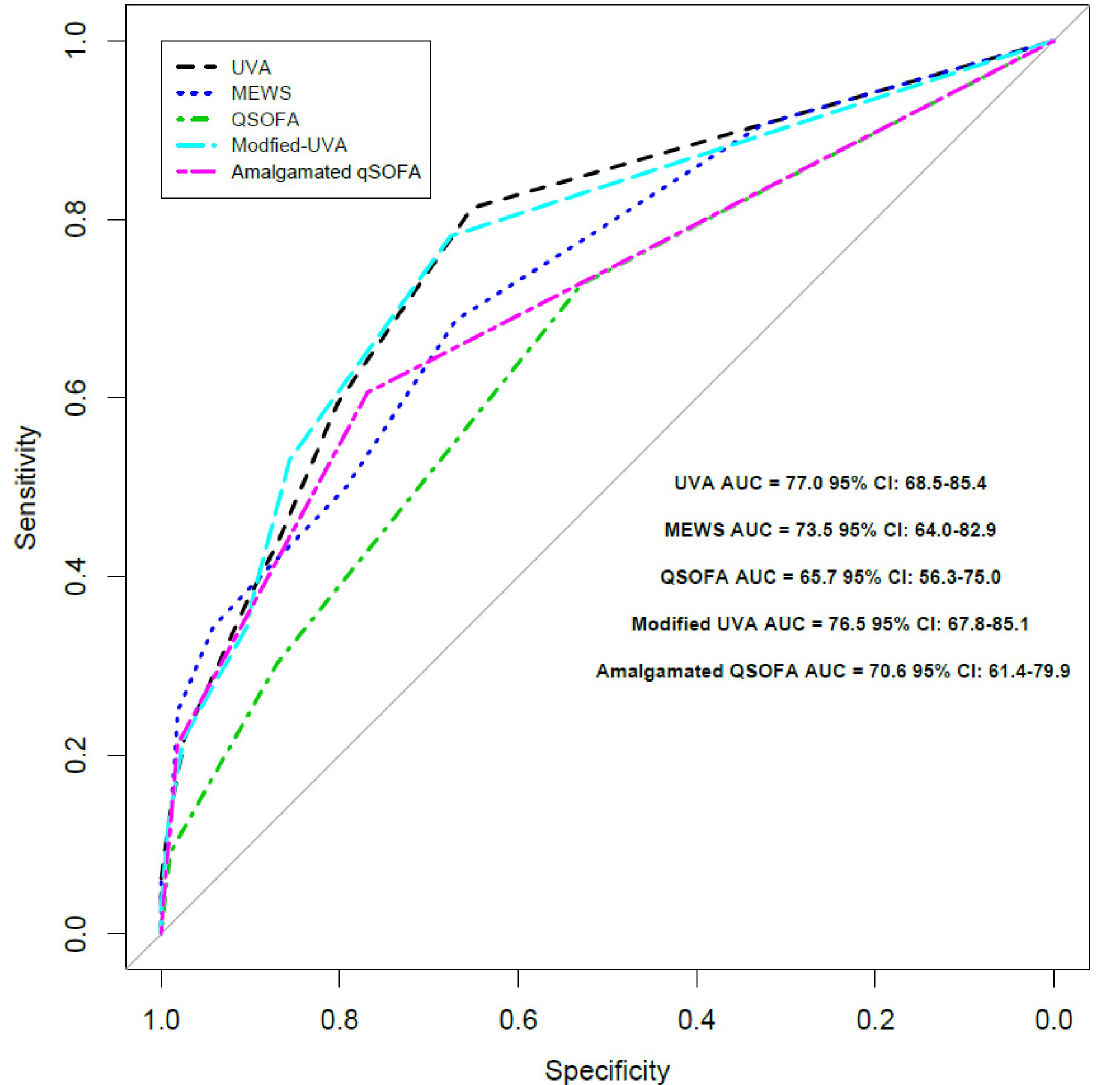
Fig 2. Receiver operating characteristic curves for different mortality risk scores used to predict mortality in adult patients admitted to hospital with acute infection in Gitwe, Rwanda.